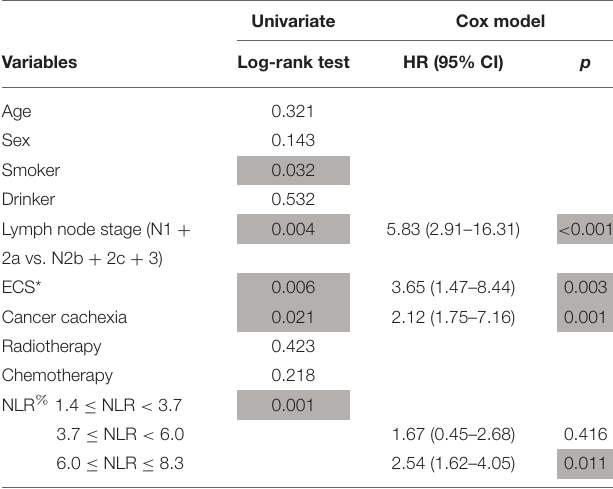
TABLE 2 | Prognostic factors for disease specific survival in patients with squamous cell carcinoma of unknown